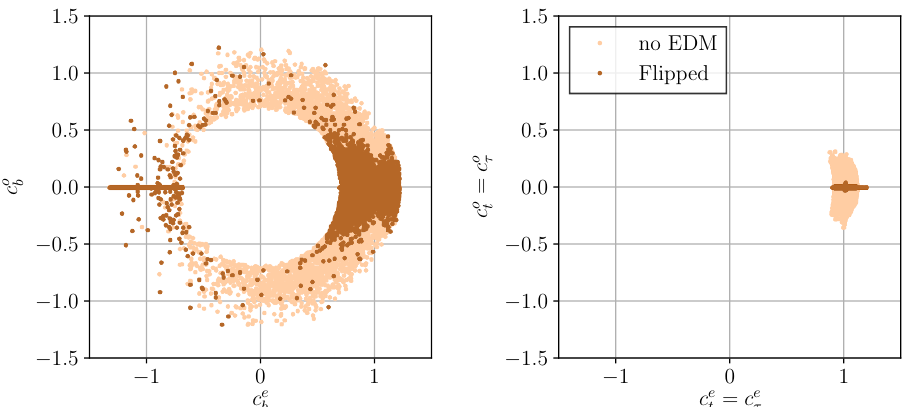
Figure 6 . C2HDM Flipped: Yukawa couplings to bottom quarks (left) and charged leptons and top quarks (right) for sample 1 (dark) and sample 2 (light).